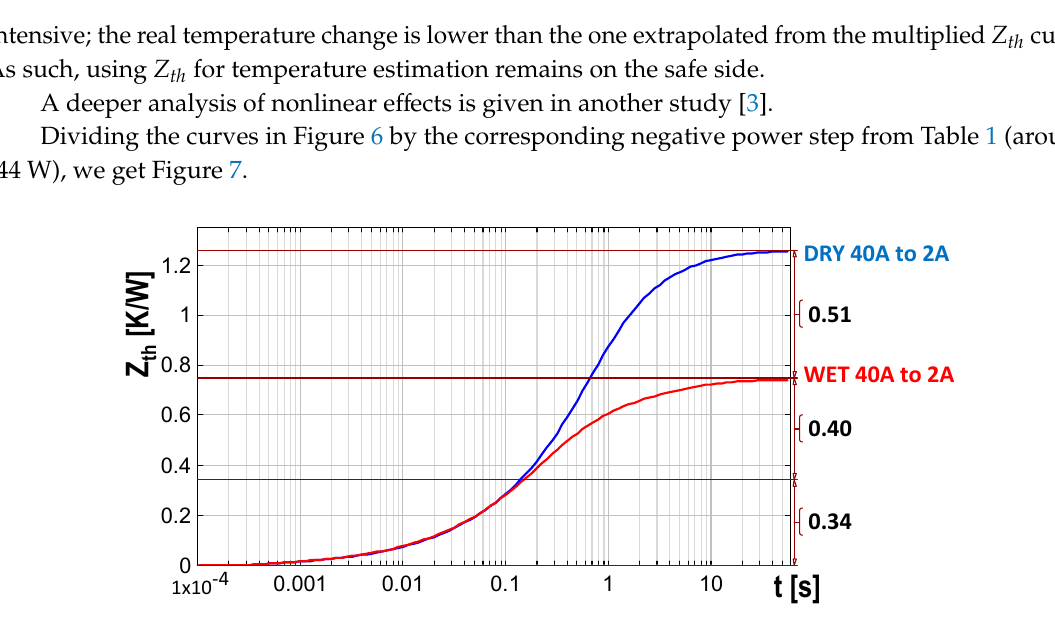
We can observe in the plot that until approximately 0.2 seconds and 0.34 K / W, the Z th curves